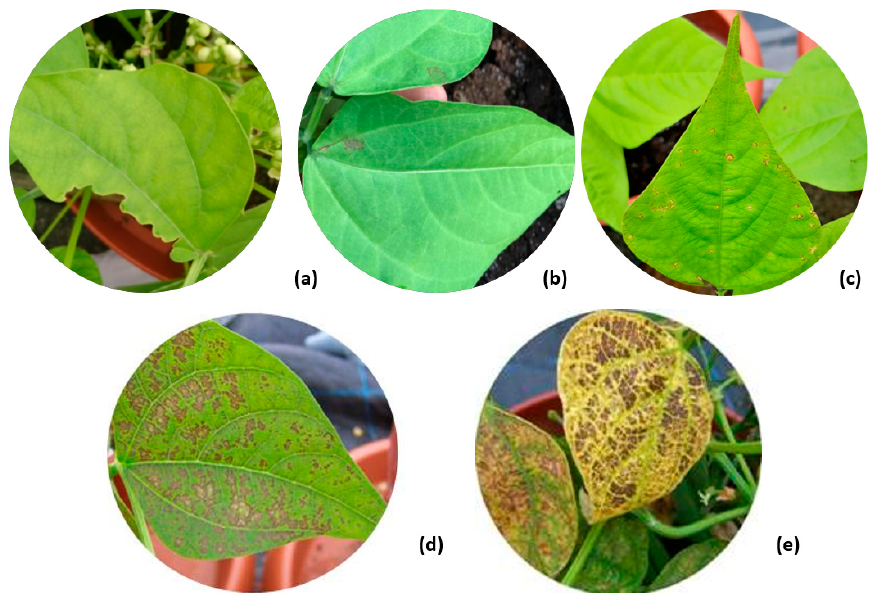
Figure 2. Ozone-induced visible foliar injury index. ( a ) No O 3 injuries but with some insect injury; ( b ) less than 5% of ozone injuries on the trifoliates; ( c ) 5% to 25% of bronze patches indicating ozone injury on the leaves; ( d ) greater than 25% of ozone injuries; and ( e ) senesced leaf that is yellow instead of green, also showing previous ozone injuries [43].